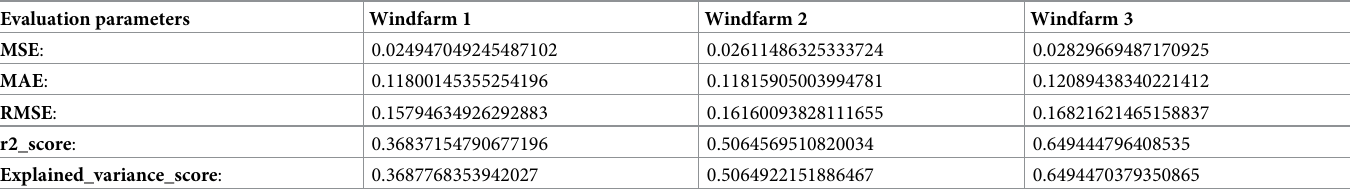
Table 3. This table shows the result for LSTM with epochs = 500 and lookback = 1. Evaluation